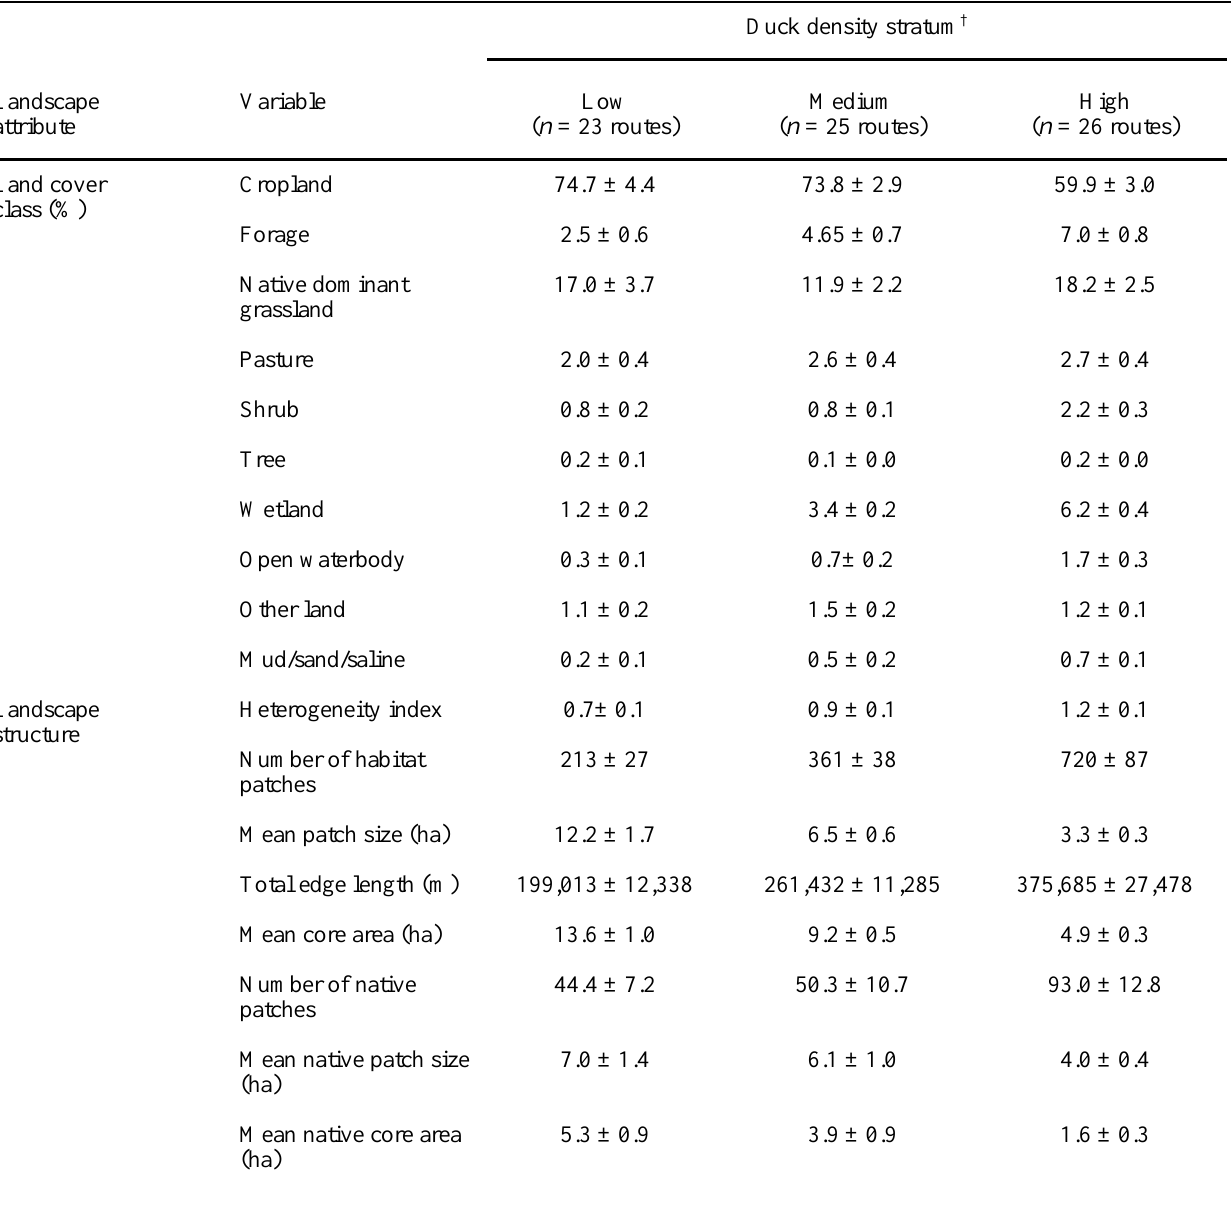
Table 3. Route-level summary statistics (mean ± 1 SE) for landscape attributes measured along each transect in southern Saskatchewan in 2001 and